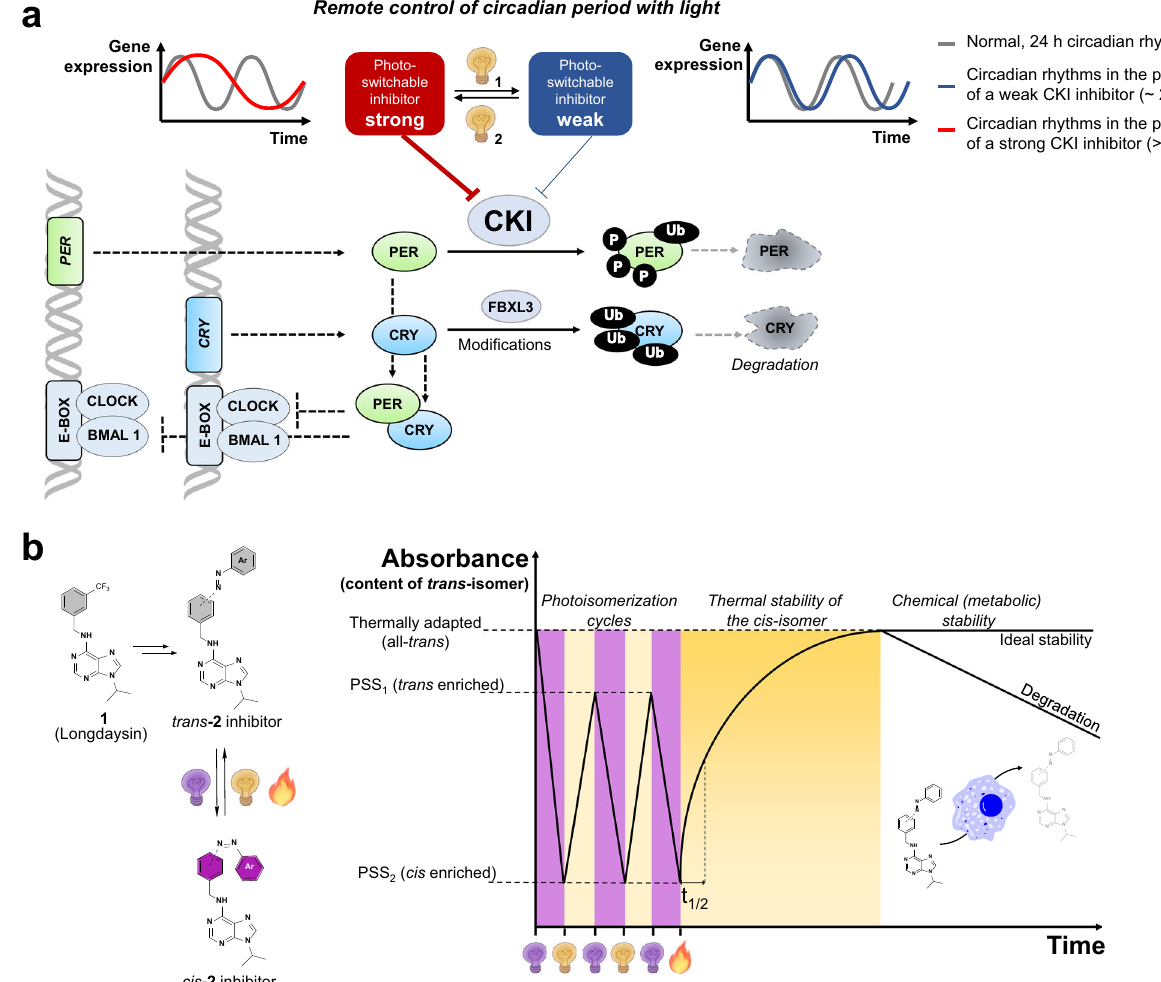
Fig. 1 The concept of the reversible chronophotopharmacology. a Schematic representation of the circadian clock transcription-translation autoregulatory feedback loop, and its photo-modulation by photoswitchable inhibitor of CKI. Both isomers of the photoswitchable bioactive molecule show inhibition of CKI, but the af fi nity can be modulated with light, with one photoisomer (shown in red) being a stronger inhibitor than the other (blue). b Key parameters of the photoswitchable circadian modulators ( 2 ), based on longdaysin ( 1 ) structure, that must be considered for a successful application in reversible modulation of the circadian rhythm. Trans -to- cis isomerization can be performed by irradiation with one wavelength (purple light), switching the thermally adapted trans -isomer (all- trans ) to the cis- enriched isomer (PSS 2 ). Back-isomerization can be achieved by another wavelength (white light) yielding the trans -enriched isomer distribution (PSS 1 ). Photochemical stability is measured by repetitive isomerization at two different wavelengths (photoisomerization cycles), and if there is no fatigue present, PSS 1 and PSS 2 will be reached each time. If left in the dark, the cis -isomer will thermally isomerize back to more stable trans -isomer (thermal stability of the cis -isomer) in a fi rst order process. The time needed for half the cis -isomer to isomerize back to the trans is called half-life (t 1/2 ). Additionally, due to lengthy assays to measure circadian rhythms (5 – 6 days), azobenzene modulators should possess metabolic stability to maintain light-dependent circadian period